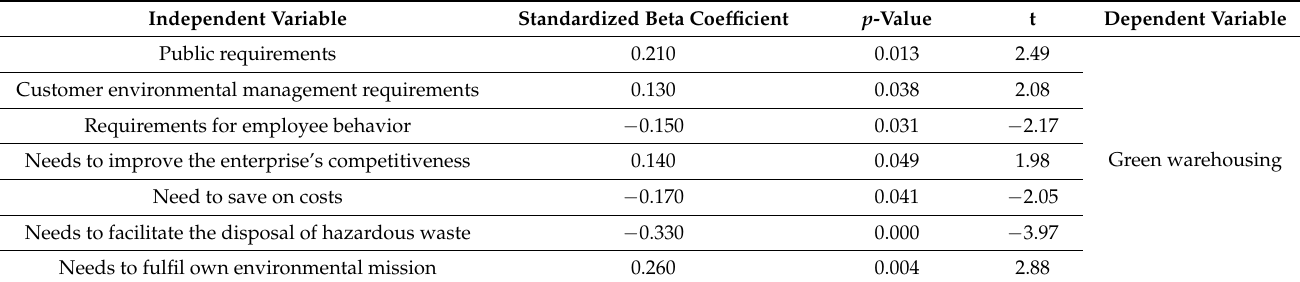
Table 5. Factors influencing the application of green